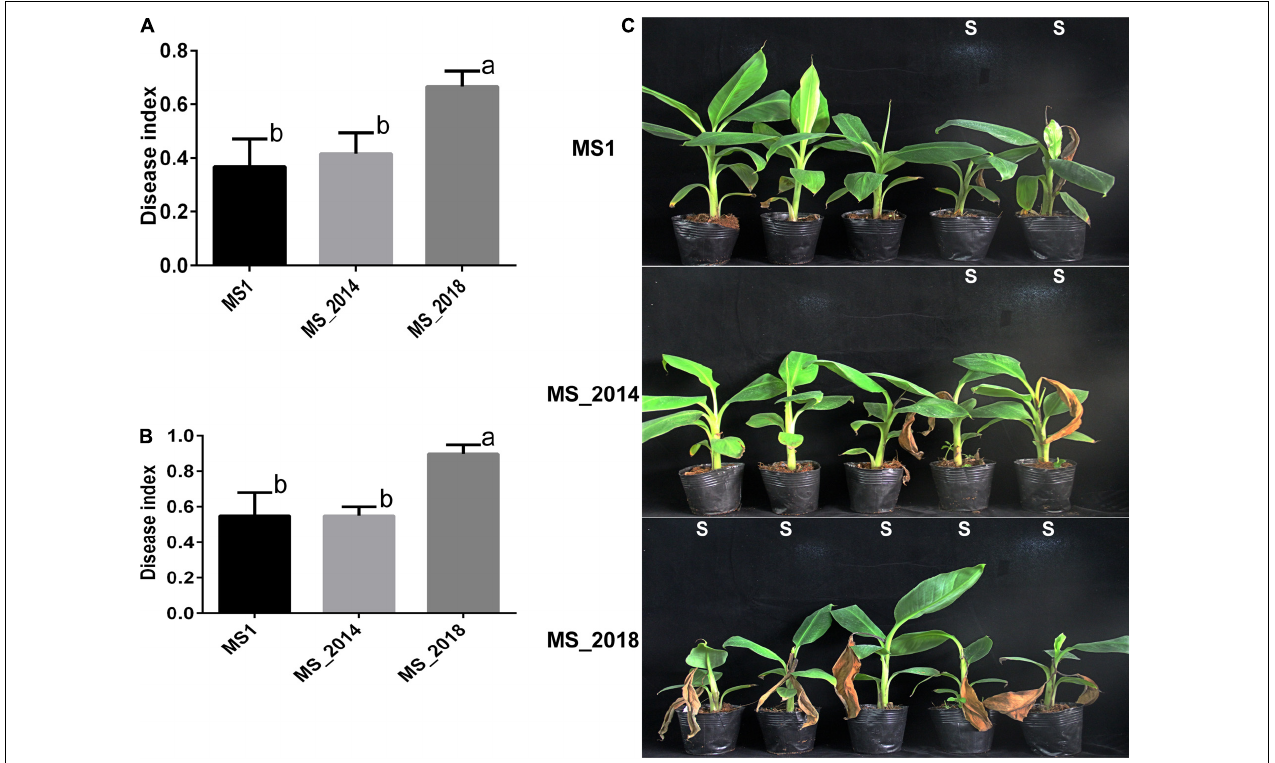
FIGURE 9 | Development of soft rot symptoms after inoculation with D . zeae strains isolated from banana. (A) Calculation of disease indexes of banana seedlings of Musa AAA Cavendish 7 days after inoculation. (B) Calculation of disease indexes of banana seedlings of Musa ABB Plantain 7 days after inoculation. Significant difference was indicated by different letters (a or b or c), while the labels with the same letter indicates no significant difference. (C) Symptoms of banana seedlings of Musa AAA Cavendish 7 days after inoculation, S indicates seedling is susceptible to pathogen and shows soft rot